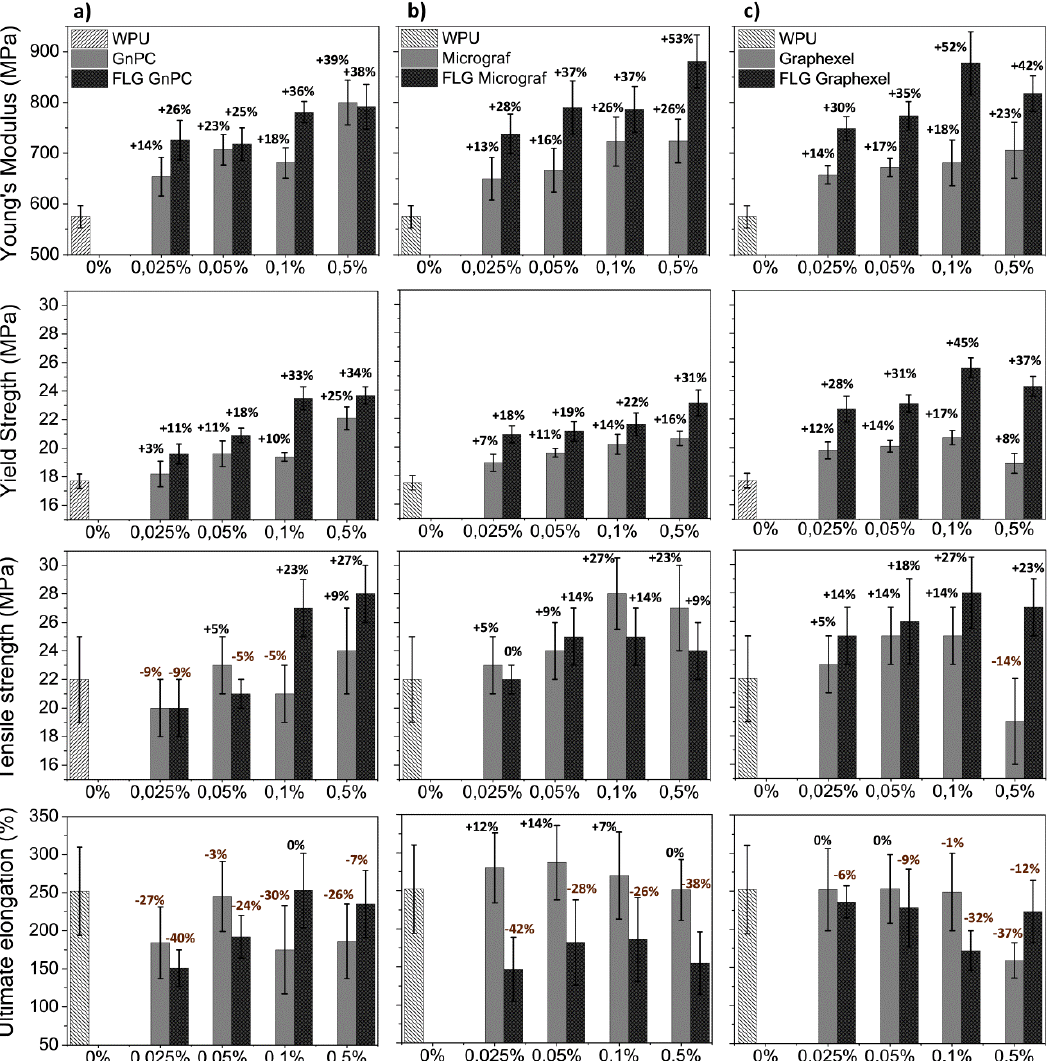
Figure 4. Young’s modulus, yield strength, tensile strength, and ultimate elongation of the waterborne polyurethane (WPU) composite films at different loadings of graphitic starting material and FLG for ( a ) GnPC, ( b ) Micrograf, and ( c ) Graphexel. The % values indicate the increase/decrease relative to WPU films.